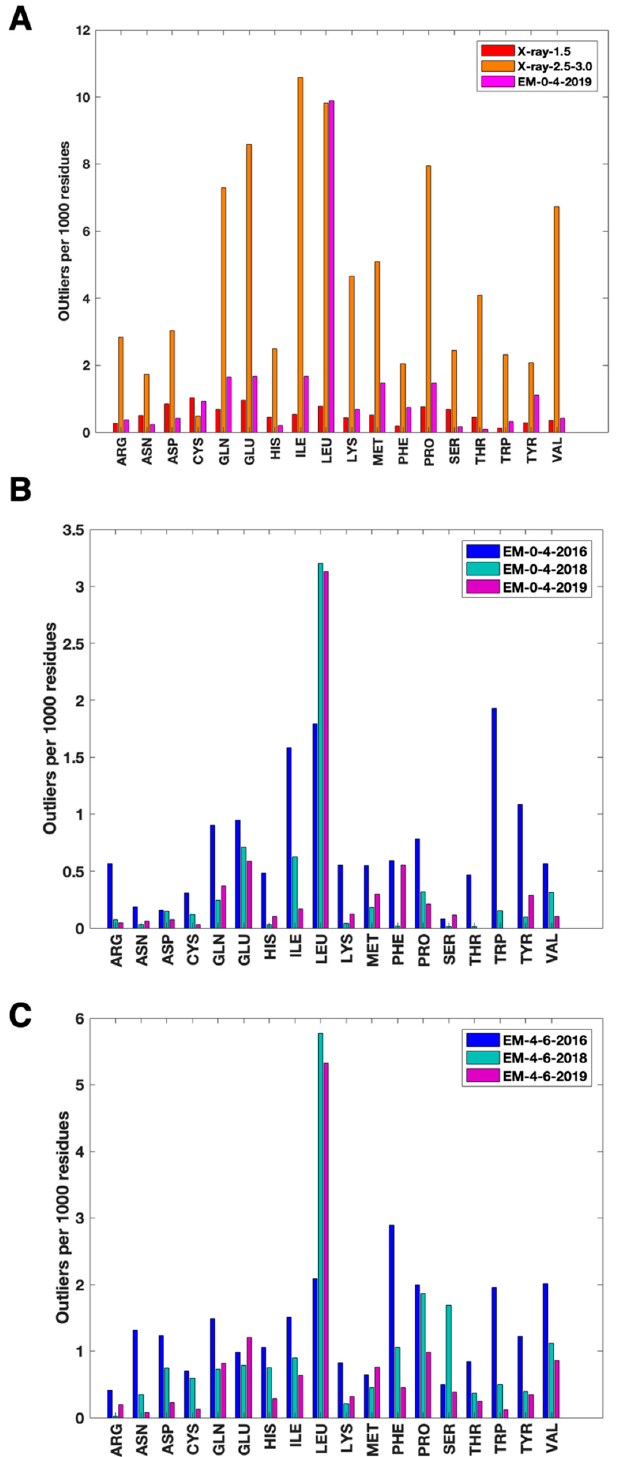
Figure 2. HBOS outliers of various residue types. ( A ) The number of outlier residues with HBOS greater than 10 per 1000 same type of residues in X-ray-1.5 (red), X-ray-2.5–3.0 (orange), and EM-0-4-2019 (magenta). ( B ) The number of HBOS outlier residues (with HBOS greater than 10) that are labeled green in wwPDB validation reports per 1000 same type of residues in EM-0-4-2016 (blue), EM-0-4-2018 (cyan), and EM-0-4-2019 (magenta); ( C ) Similar information as in ( B ) for three di ff erent datasets: EM-4-6-2016 (blue), EM-4-6-2018 (cyan), EM-4-6-2019